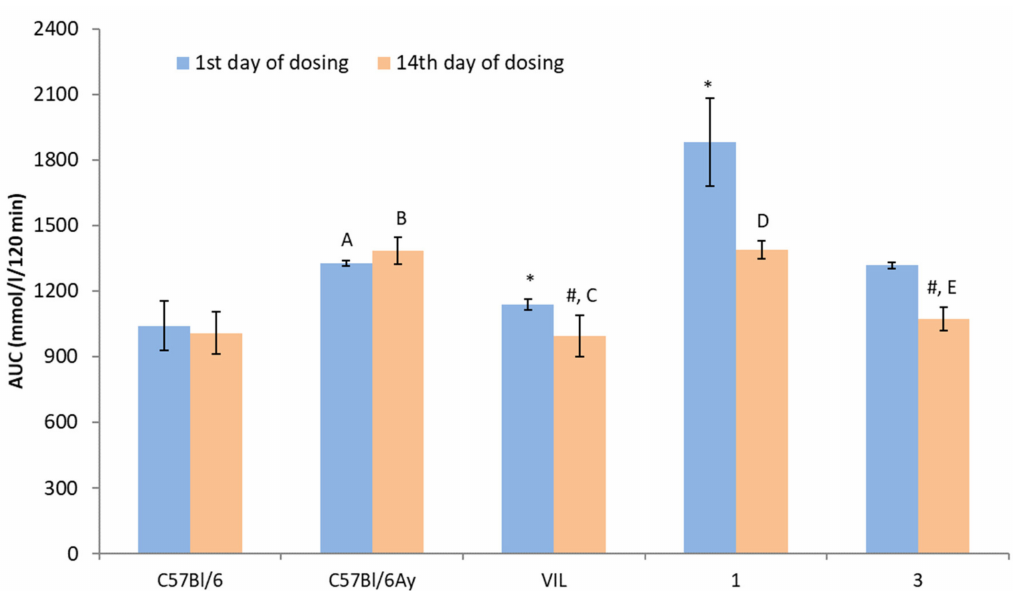
Figure 5. OGTT results in AY mice. AUC: area under the glycemic curve; * p < 0.05 vs. untreated AY mice on the first day of dosing; # p < 0.05 vs. untreated AY mice on the 14th day of dosing; A p < 0.05 vs. untreated C57BL / 6 mice on the first day of dosing; B p < 0.05 vs. untreated C57BL / 6 mice on the 14th day of dosing; C p < 0.05 vs. vildagliptin (VIL) on the first day of dosing; D p < 0.05 vs. compound 1 on